Question: Describe this figure in one sentence.
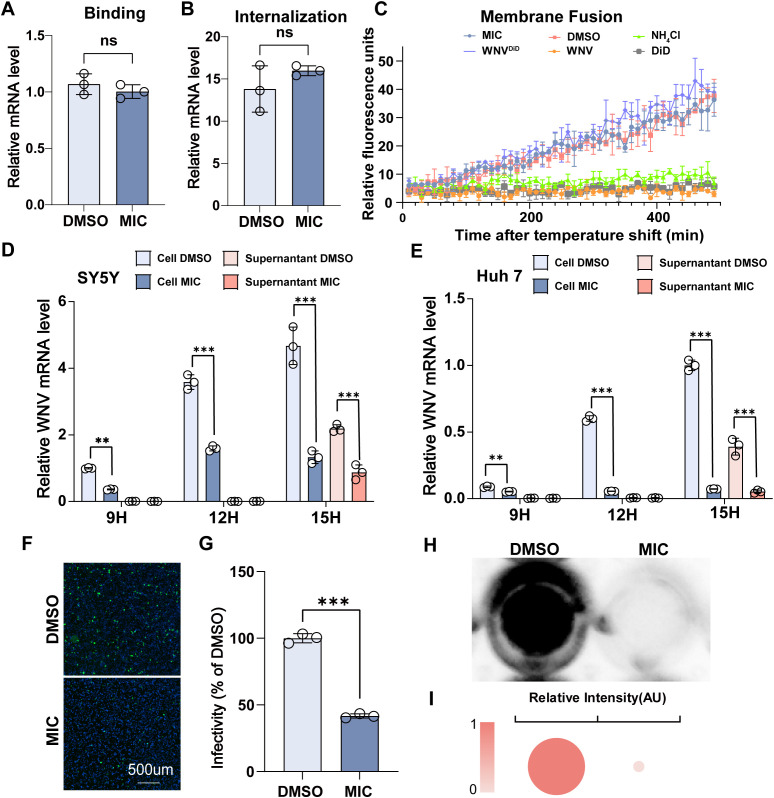
Answer: Miconazole inhibits WNV replication. (A) Viral binding assay: SH-SY5Y cells incubated with WNV (MOI = 10) and miconazole (20 μM) at 4 °C for 90 min; bound viral RNA quantified by RT-qPCR. (B) Viral internalization assay: cells treated as in (A) , shifted to 37 °C for 2 h, proteinase K-treated, and analyzed by RT-qPCR. (C) Membrane fusion assay: WNV DiD (MOI = 1)-infected cells treated with miconazole (20 μM), NH 4 Cl (25 mM), or DMSO; fluorescence recorded every 15 min. DiD: DiD dye alone; WNV: unlabeled virus. (D, E) WNV genome RNA-transfected SH-SY5Y (D) and Huh7 (E) cells treated with miconazole (20 μM); viral RNA in cells and supernatant quantified at 9, 12, and 15 hpt. (F–I) WNV replicon-transfected SH-SY5Y cells treated with miconazole (20 μM) for 48 hours: (F, G) NS1 immunofluorescence; (H, I) luciferase activity. Data represent the mean ± SD of three biologically independent experiments (n = 3). ns, not significant; **P < 0.01, ***P < 0.001 vs. DMSO control.